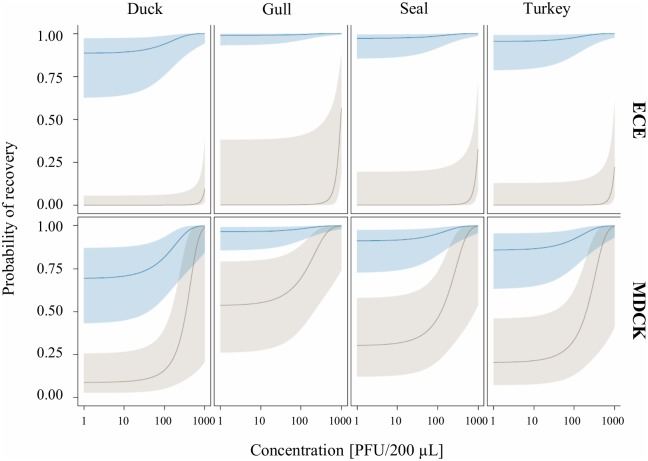
Predicted probability of recovering different influenza A virus strains from inoculated sediment (brown) and freshwater (blue) samples by from embryonated chicken eggs (ECE) and Madin-Darby Canine Kidney (MDCK) cells.Virus concentration (infection dose) is shown on a log scale on the x-axis and the predicted probability is shown on the y-axis. The dark lines indicate the predicted probability of recovery with increasing initial virus concentration. The blue and brown distributions around the lines represent the 95% confidence intervals.